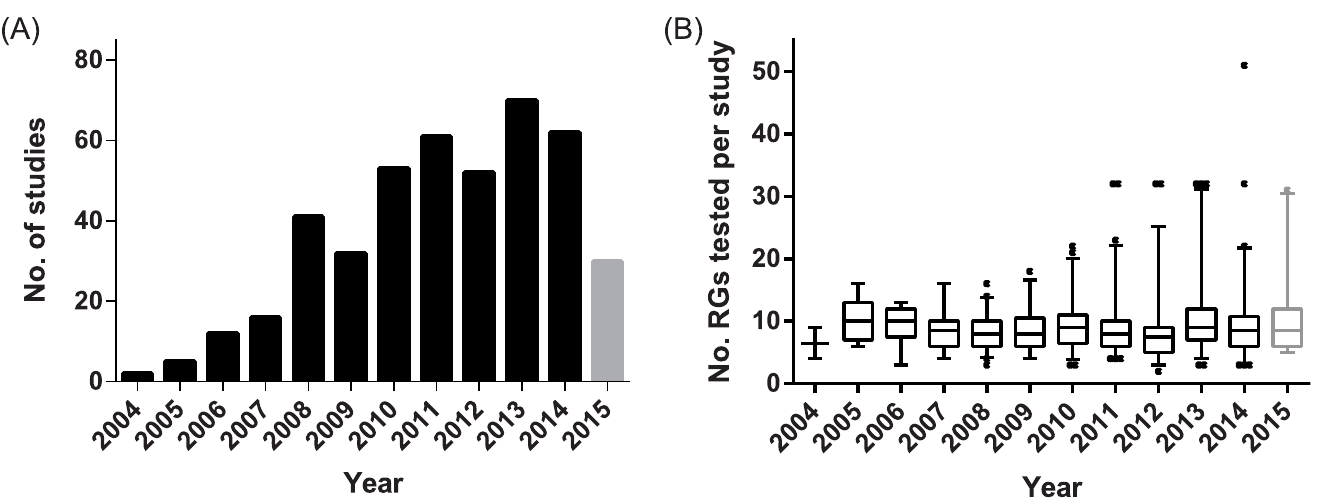
Fig 5. Publication of studies testing a panel of RGs for expression stability. Papers included in LitRev2 showing (A) Temporal trend, and (B) Median and interquartile range of number (no.) of RGs included in stability panels per year, where whiskers span the 5 – 95 percentiles. Data for 2015 are shown in grey as this comprises the months January to June 2015 only.